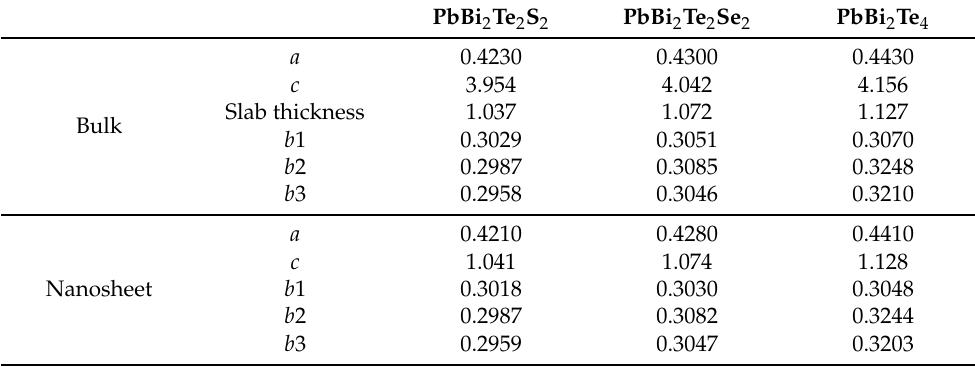
Table 1. Calculated lattice constants, slab thickness and bond lengths as labeled in Figure 1 ( b 1 is Te-Bi, b 2 is Bi-S/Se/Te and b 3 is S/Se/Te-Pb) of PbBi 2 Te 2 X 2 (X = S,Se,Te) in bulk and nanosheet structures optimized with the WC functional. All data in